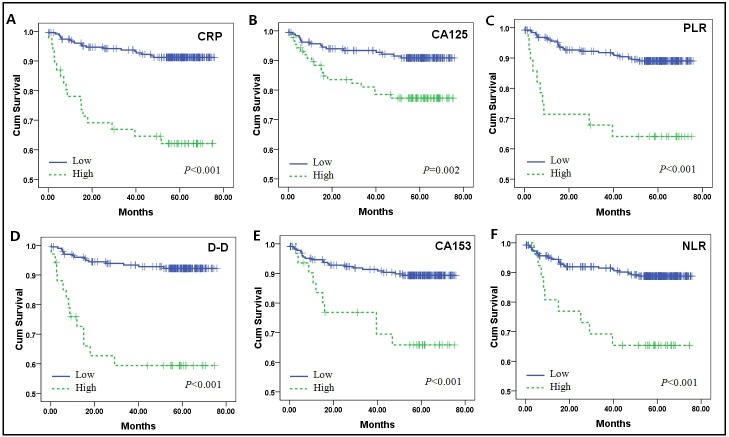
Kaplan-Meier survival estimates for patients with endometrial cancer.Disease-specific survival curves of patients grouped as low and high risk, according to biomarker cut-points (log-rank test used to calculate P-values).